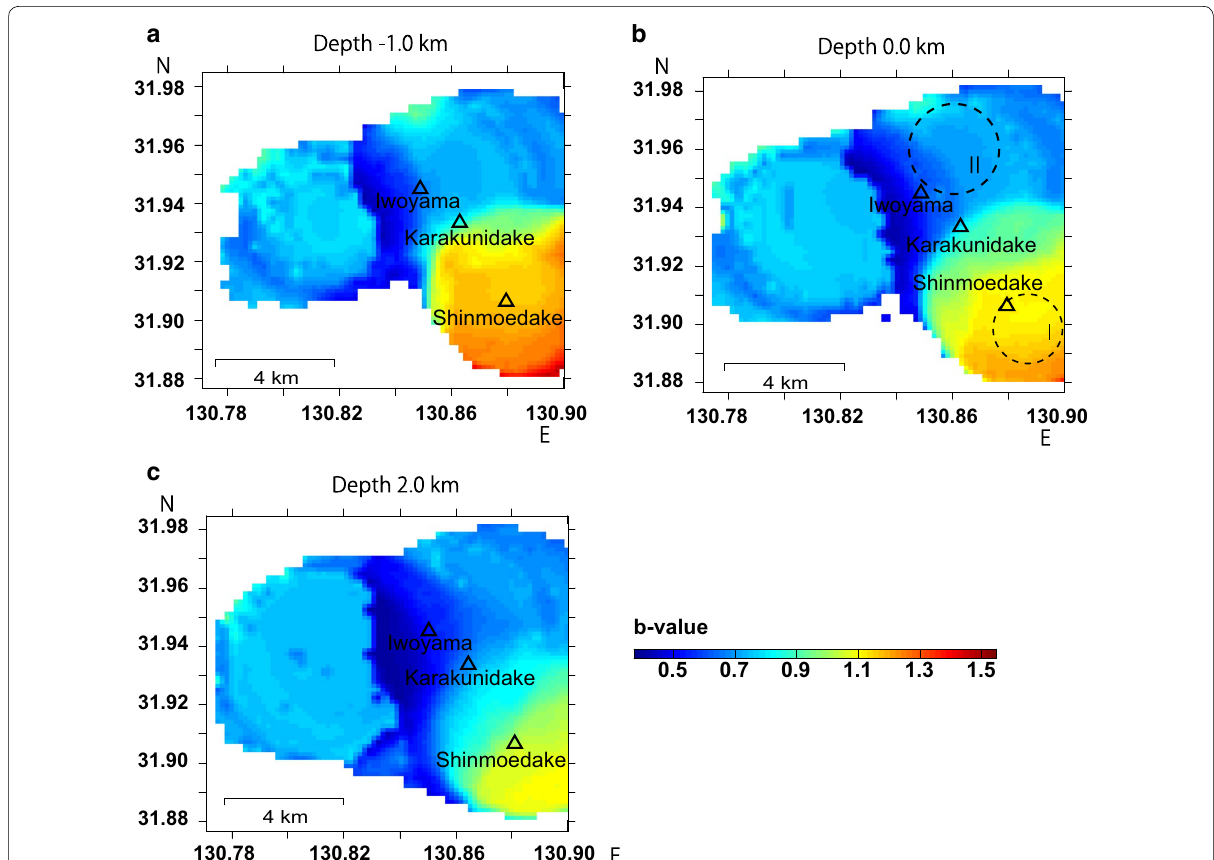
Fig. 2 Spatial distribution of b -values in the region indicated by the black dotted square in Fig. 1 at depths of a The b -values of grids with spatial resolution coarser than 3.5 km are not shown. Black bold circles indicate regions where p value analysis was